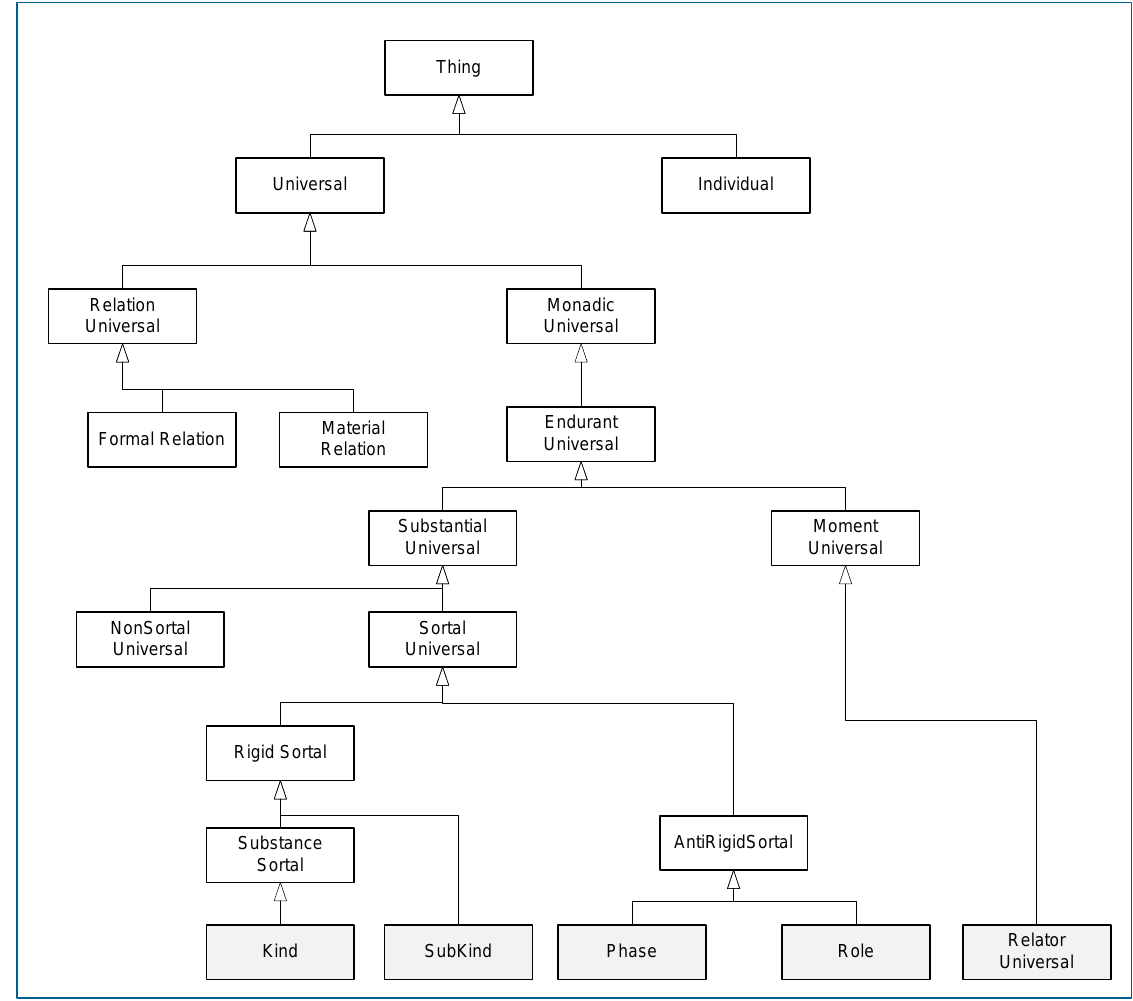
Figure 10. Relation types and (monadic) entity types – UFO